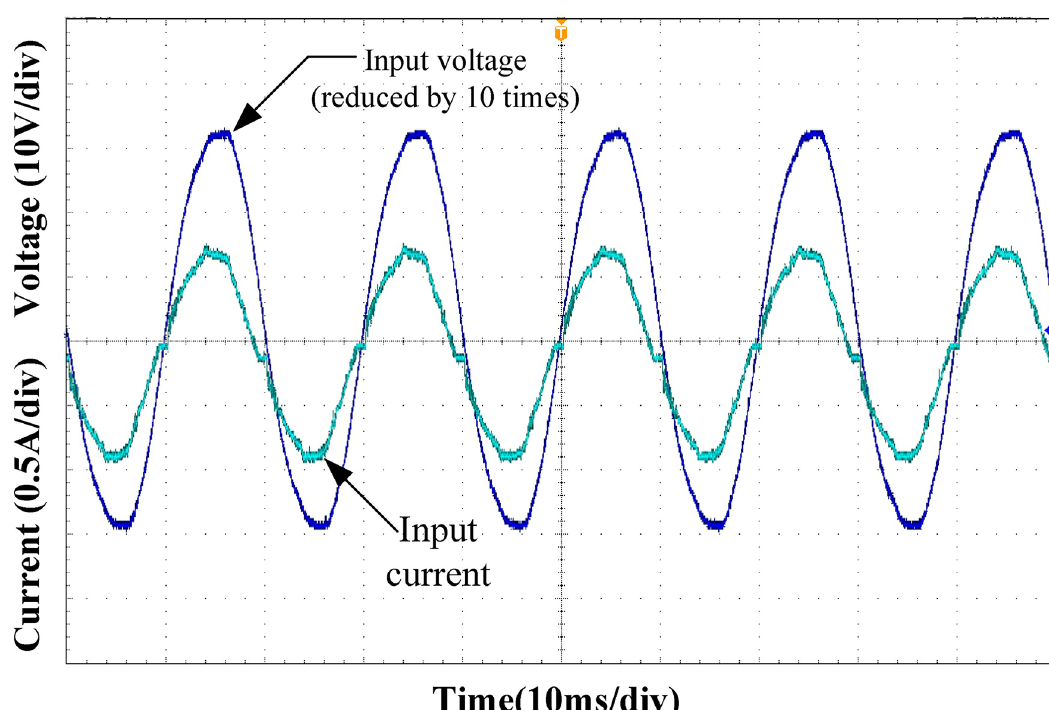
Fig 18. Input voltage and current at full load.